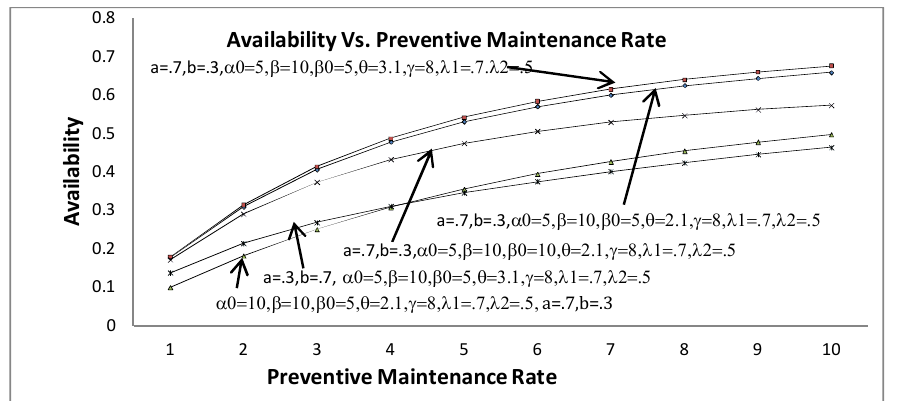
Fig 2. MTSF Vs Preventive Maintenace Rate Fig. 2. MTSF Vs. Preventive Maintenance Rate